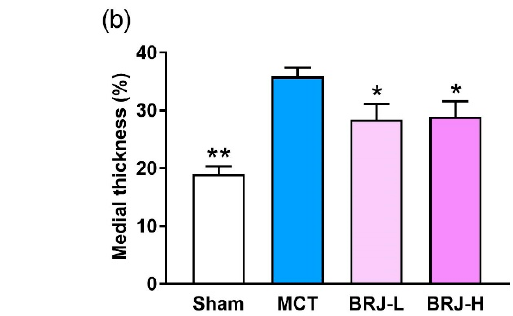
Figure 2. Effects of BRJ supplementation on RV dysfunction in MCT-injected rats. ( a ) representative images, ( b ) RVSP. Each column and bar represent the mean ± SEM values of 6–9 experiments. One-way analysis of variance with the Holm–Sidak post hoc test was performed to determine the significance; ** p < 0.01, compared to the MCT group. Abbreviations: BRJ, beetroot juice; RV, right ventricle; MCT, monocrotaline; RVSP, right ventricular systolic pressure; BRJ-L, low-dose beetroot juice; BRJ-H, high-dose beetroot juice.